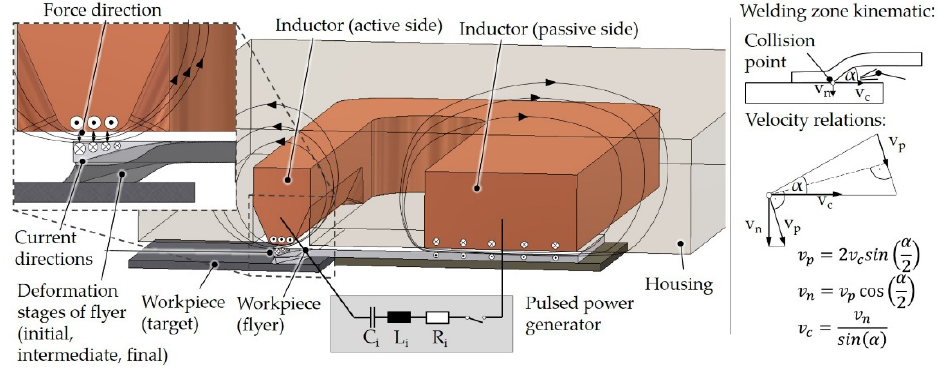
Figure 1. Electromagnetic sheet metal welding process setup and process parameter kinematic.